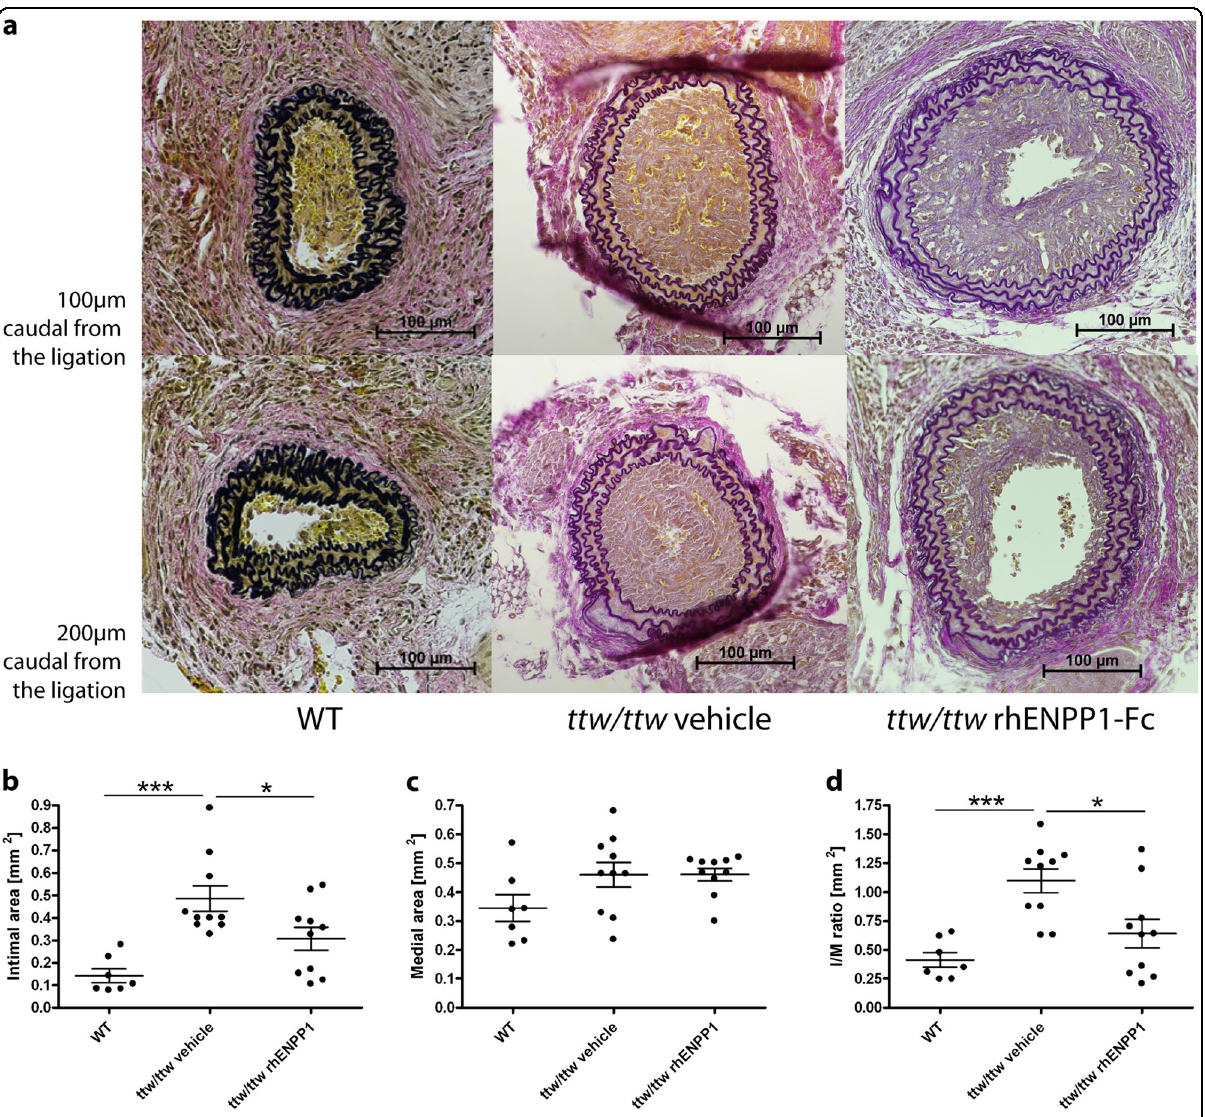
Fig. 5 Therapeutic administration of rhENPP1-Fc inhibits intimal proliferation after carotid ligation in ttw/ttw mice RhENPP1-Fc treatment was started 7 days after carotid ligation, and serial sections of the left carotid arteries were taken 14 days after carotid ligation. Histological analysis (Von Gieson ’ s stain) was performed on sections taken either 100 (upper panel) or 200 (lower panel) µm from the point of ligation from WT, vehicle- treated ttw/ttw or rhENPP1-treated ttw/ttw − mice, shown from left to right ( a ). The scale bar represents 100 µm. Morphometric quantitation was performed on intimal ( b ) and medial ( c ) areas, and the I / M ratio was calculated ( d ). Values are presented as the mean ± SEM, n = 7 for WT, n = 10 for vehicle-treated ttw/ttw or rhENPP1-treated ttw/ttw - mice, *** p < 0.001, * p < 0.05 (one-way ANOVA multiple group comparison followed by